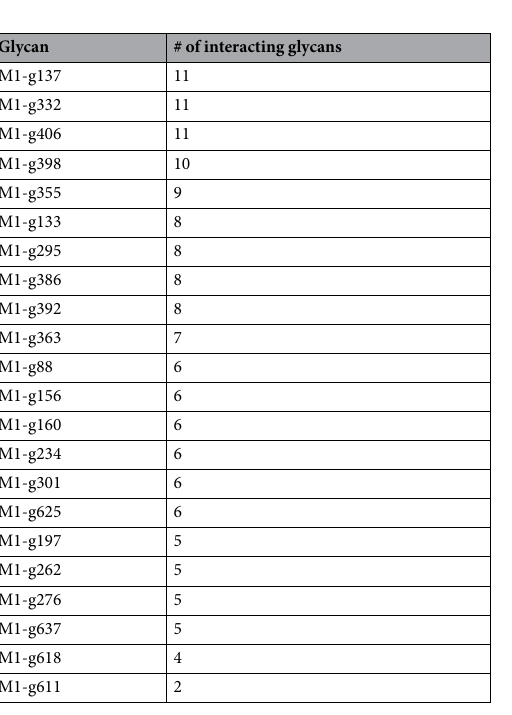
Table 1. Number of glycans interacting with each glycan in monomer 1 based on overlap coefficients > 0 obtained from the 3D Cartesian volumes. Results are sorted from the largest to smallest number of interacting